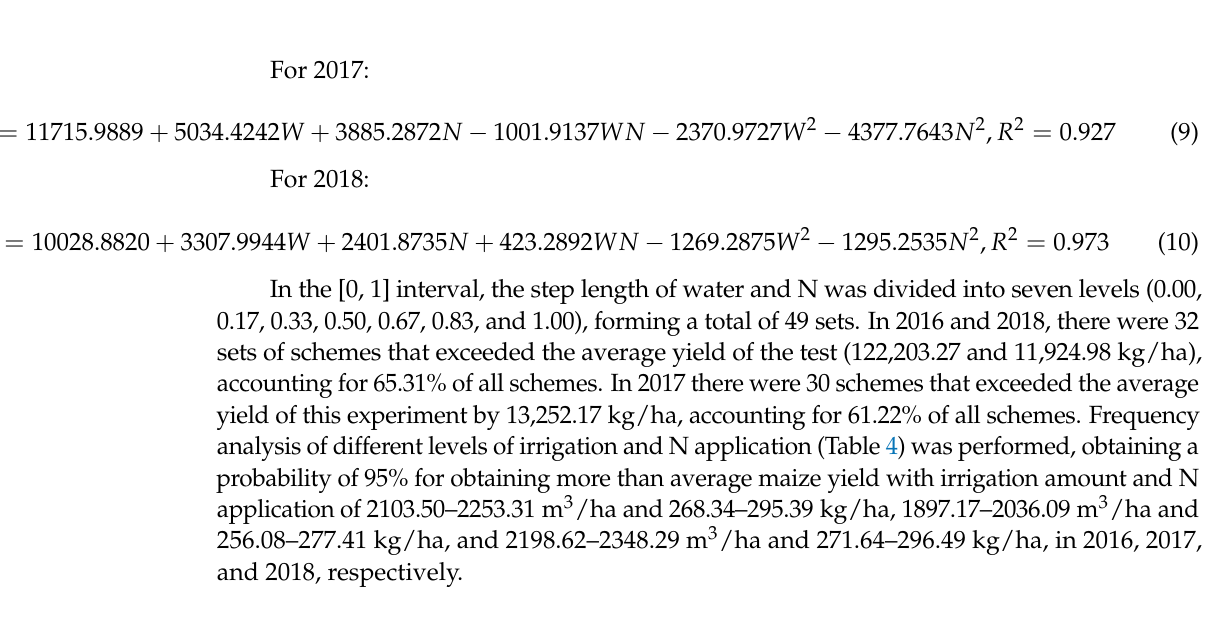
Table 4. Factor value of the frequency distribution and proportion plan with grain yield surpass